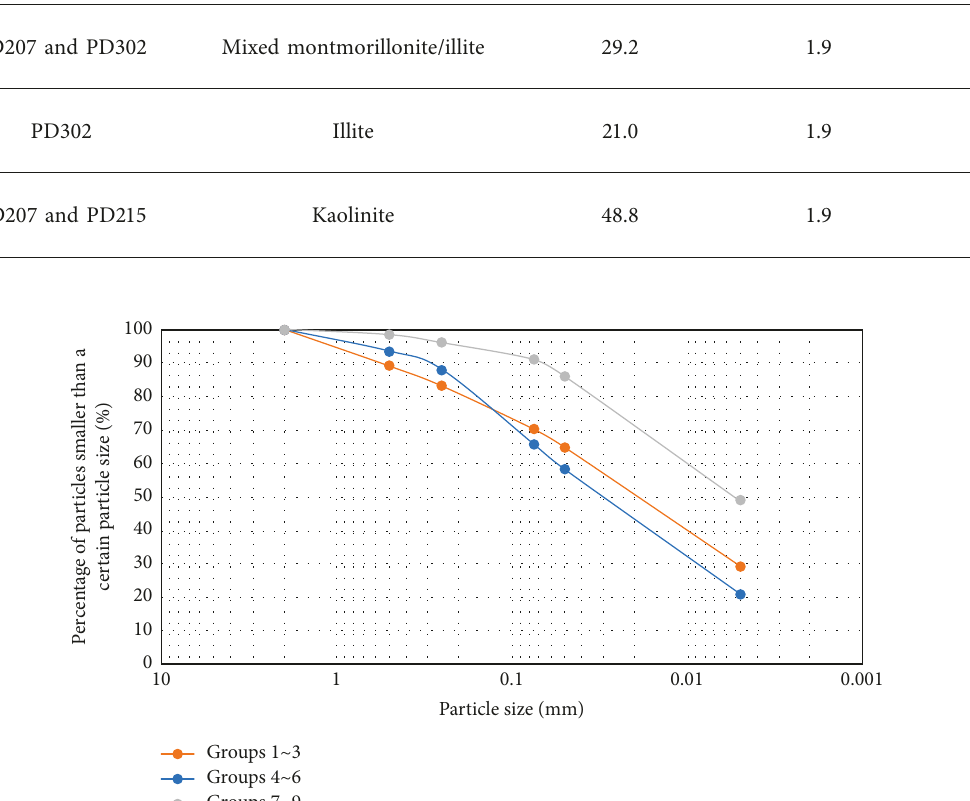
Figure 4: Grading of the particle